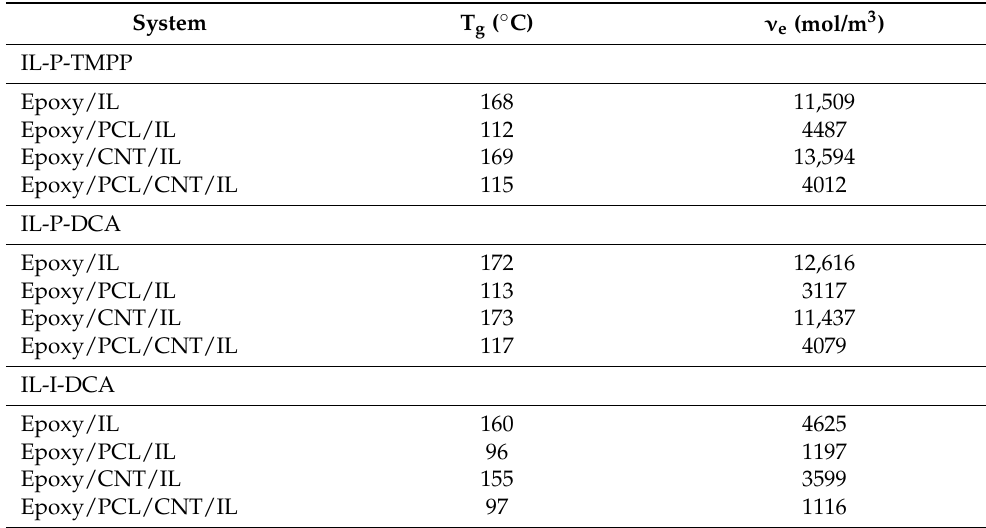
Table 2. The glass transition temperatures and crosslinking densities of the epoxy/PCL/CNT/IL NCs and the reference epoxy/IL, epoxy/PCL/IL, and epoxy/CNT/IL systems, cured with the three different